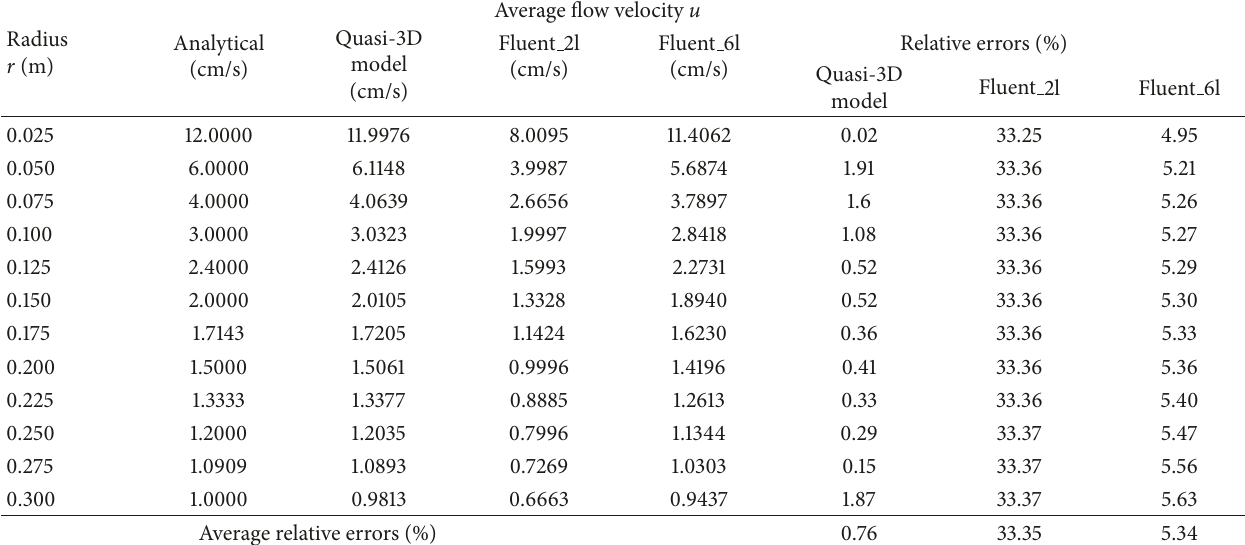
Table 4: Average flow velocity at different radiuses at t = 20 s in Case 1.